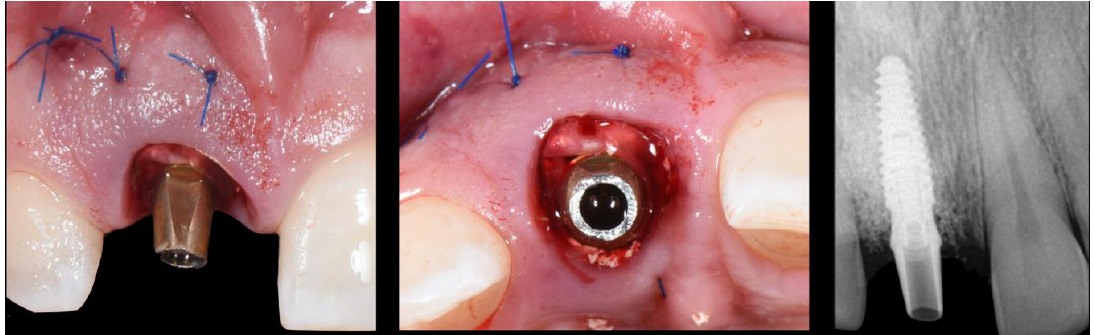
Figure 8. Vertical mattress sutures and radiographic control.